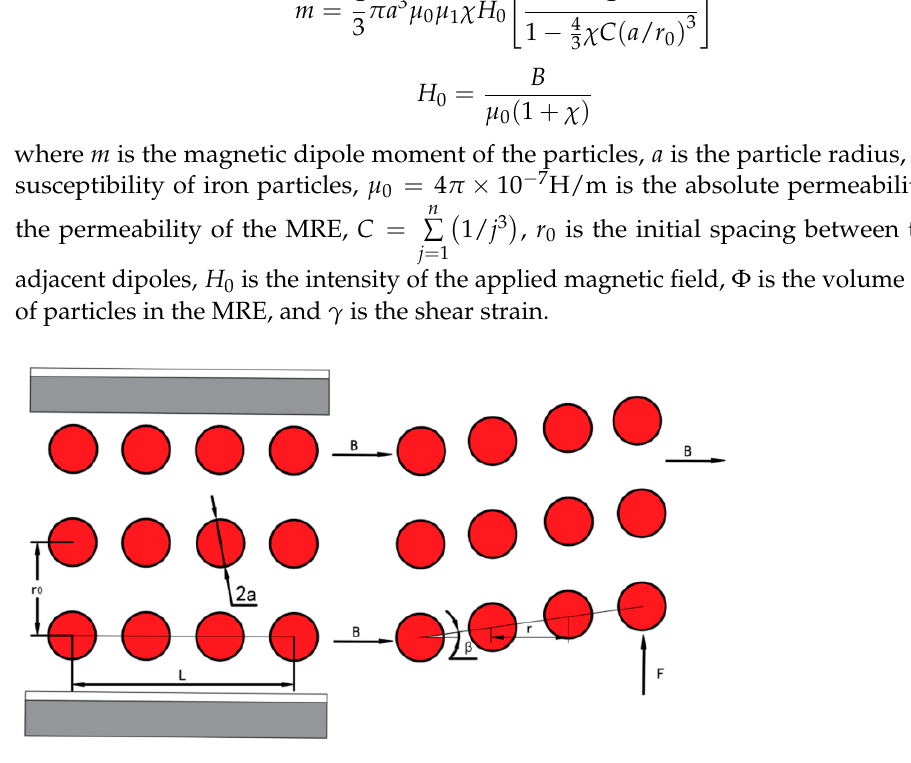
Figure 3. Predeformed and postdeformed structures of chains in the elastomer.